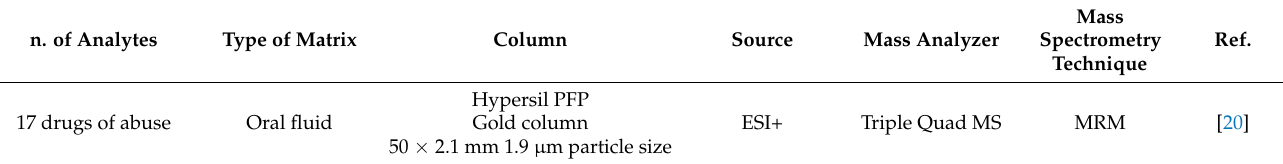
Table 2. LC-MS/MS